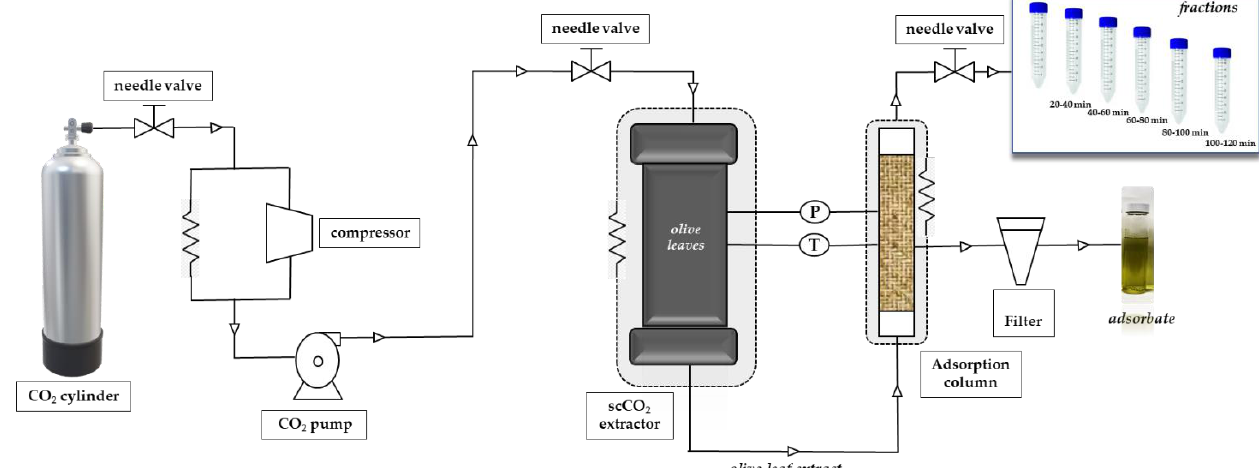
Figure 1. Scheme of the adsorbent-assisted supercritical CO 2 extraction system. The adsorbent-assisted supercritical CO 2 extraction process was carried out at 30 MPa and 60 °C dynamically for 120 min. The adsorbent material was placed in a stain- less-steel cylindrical adsorption cell (29 cm length and 0.65 cm i.d., for a total column volume of 38.5 cm 3 ) after the extraction cell, as shown in Figure 1; adsorbents were packed into the adsorption column with glass wool and high-quality cellulose disk fil- ters were located at the entrance and exit of the column to prevent plugging. Carbon di- oxide passed through the supercritical extraction cell and the extracted solute(s) was adsorbed dynamically by the packed material in the adsorption column; the whole pro- cess was carried out at the same p and T, that is, 30 Mpa and 60 °C. Fractions were col- lected every 20 min at the exit of the adsorption column, after depressurization through an expansion valve (Parker Autoclave Engineers, Erie, PA, USA). After 120 min, com- plete depressurization of the system was carried out for a total of 30 min. Non-desorbed compounds remaining in the adsorbent after the whole process were recovered by washing the material with high-purity grade ethanol (VWR Chemi- cals-BDH, Barcelona, Spain) by agitation at room temperature for 2 h and filtered (they were called adsorbates). This treatment was applied for all materials except for zeolite that required a further centrifugation step at 10000 rpm for 10 min. The supernatant was passed through a filter of 0.45 µm pore size and 13 mm diameter. All experiments were done in duplicate. Extraction yield (%) of all fractions was expressed on a dry weight ba- sis. Recovery values (%) for a particular family of terpenes (Ci = C10, C15, C20, or C30) obtained at a defined extraction time (t = (0 – 20), (20 – 40), (40 – 60), (60 – 80), (80 – 100]) or (100 – 120) min), using a certain type of adsorbent material (s = SS, S60, S60P, S150, S150P, ZeAmG, or AO) was calculated according to equation (1) as follows: (1) where A ci(t,s) is the abundance of the target terpenes family extracted under fixed condi- tions of time and adsorbent; and ∑ A ci(control) is the sum of abundances of all terpene fami- lies (total terpenes abundance) obtained under control conditions ( t = 120 min, without adsorbent). From all samples collected during the kinetic process plus adsorbates, a total of 32 natural extracts from olive leaves enriched in terpenoids were obtained. This number comes from the 7 adsorbents and control (no adsorbent) at 3 points of kinetic extraction (t = (0 – 20), (40 – 60), and (100 – 120) min) tested, plus, the 7 adsorbates fractions that re- % 𝑅𝑒𝑐𝑜𝑣𝑒𝑟𝑦 𝐶 𝑖 𝑡 , 𝑠 =